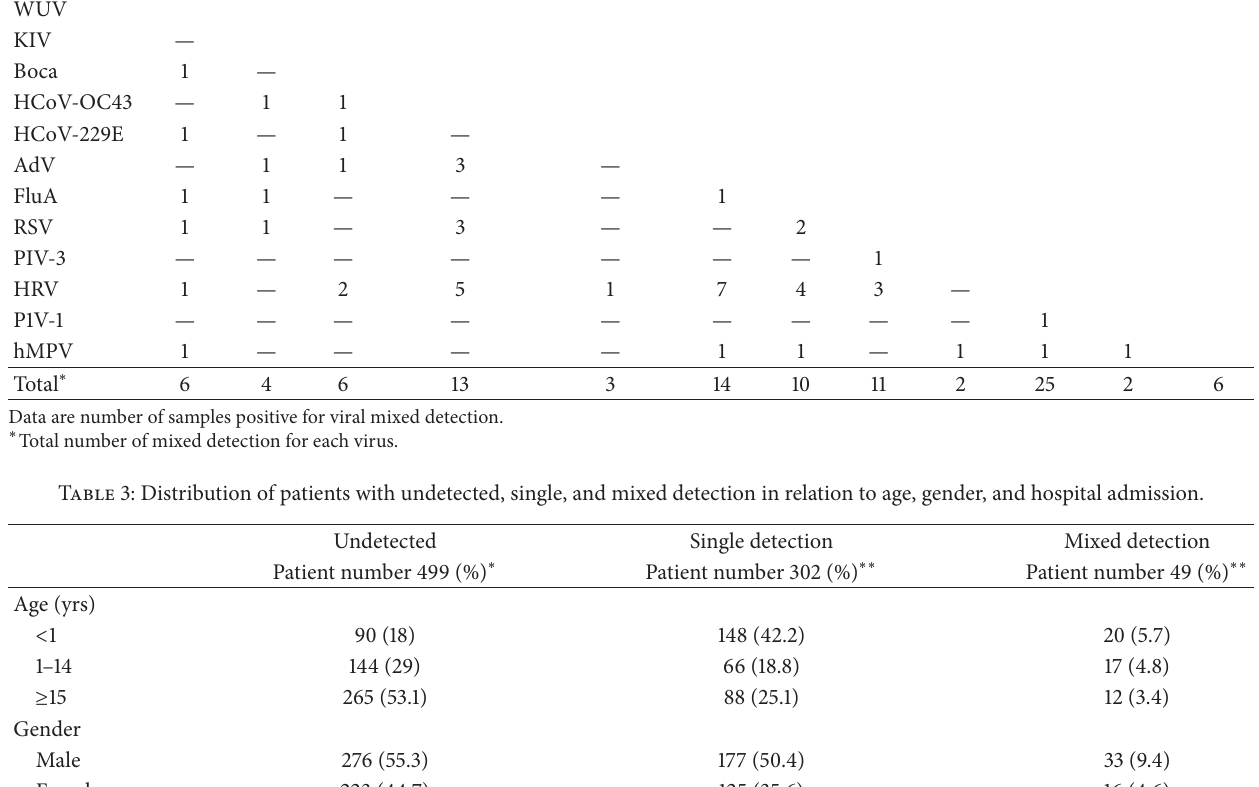
Table 2: Frequency of viral mixed detection for twelve respiratory viruses. Viruses